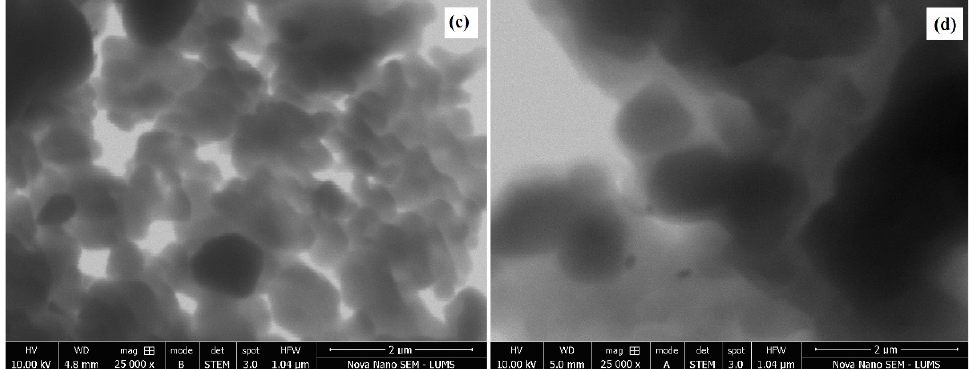
Figure 5. ( a ) SEM micrograph of pristine MgFe 2 O 4 , ( b ) SEM micrograph of amine-functionalized MgFe 2 O 4 , ( c ) STEM micrograph of pristine MgFe 2 O 4 , ( d ) STEM micrograph of amine-functionalized MgFe 2 O 4 .